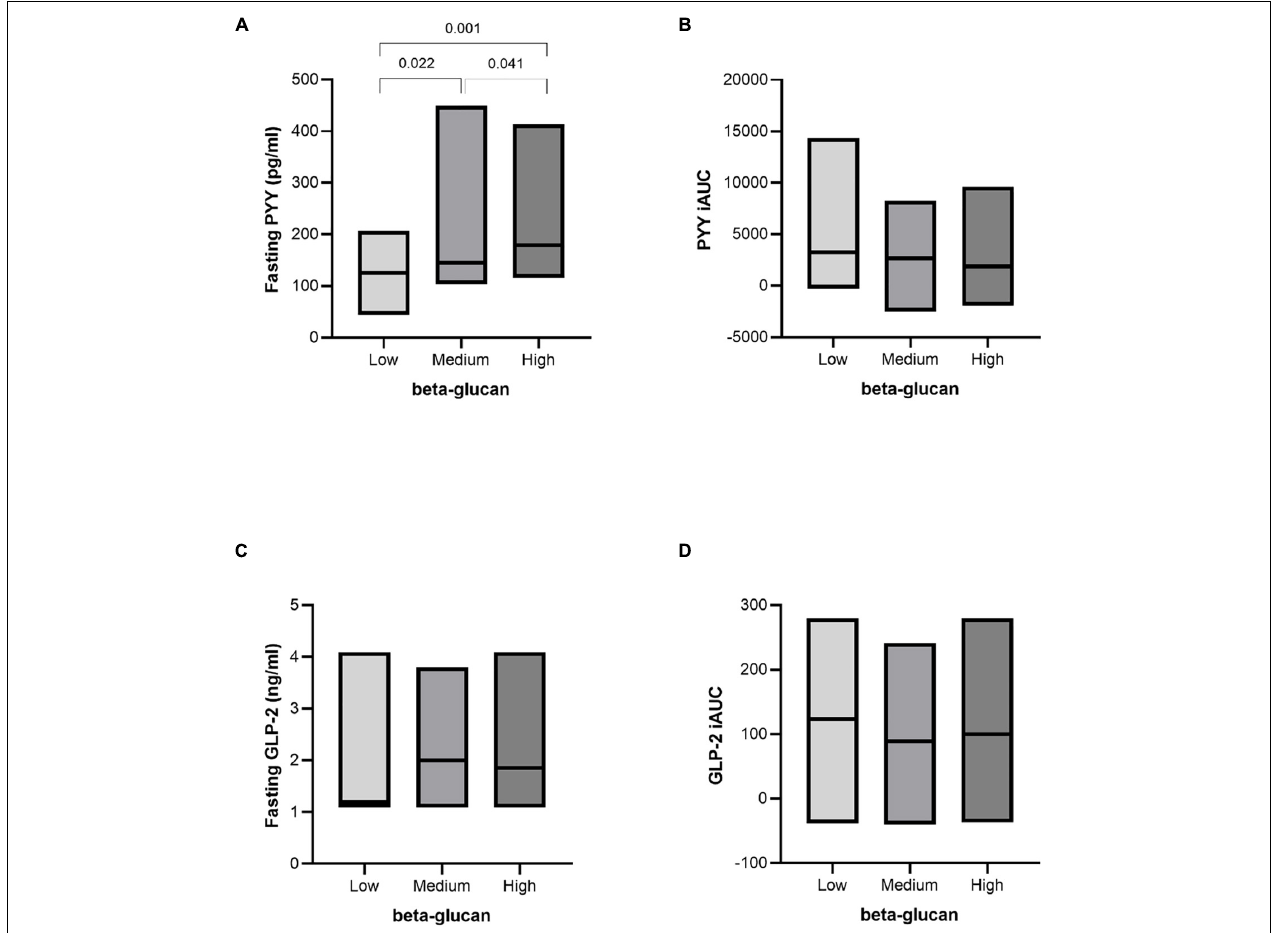
FIGURE 5 | Fasting and postprandial response of PYY and GLP-2 after intake of granola with cereal beta-glucan. Fasting values (A,C) and the incremental area under the curve (B,D) after an OGTT after consuming low, medium and high amount of beta-glucan for three days. Data is given as median (25 th –75 th ). Significant differences are calculated with Friedman’s Anova followed by Wilcoxon signed rank test. Significant differences are presented with